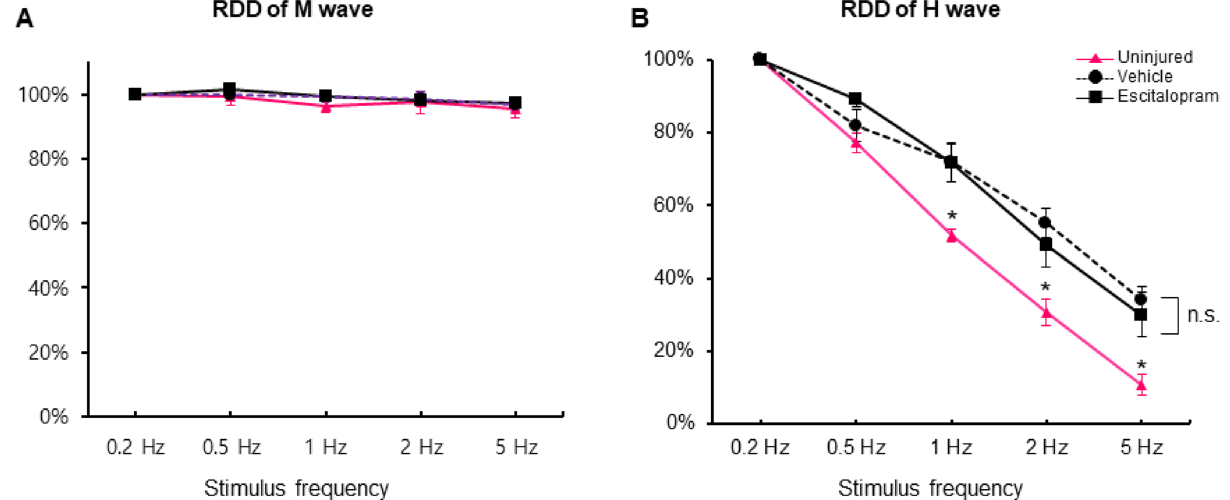
Figure 3. Rate-dependent depression (RDD) of the H-reflex in the experimental groups. ( A ) The rate- dependent depression (RDD) of the M wave in each group is shown with different stimulation rates. ( B ) Graphs present the RDD of the H-wave in each group (magenta line with triangular plots: uninjured group, dashed line with round plots: vehicle-treated group, black line with rectangular plots: escitalopram-treated group). * P < 0.05, n.s.